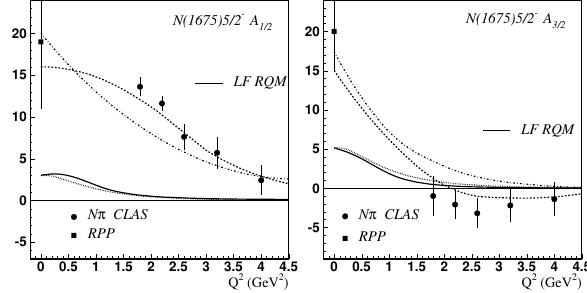
Fig. 19 Helicity amplitude A 1 / 2 (left) and A 3 / 2 (right) for N + (1675)5 / 2 − off proton